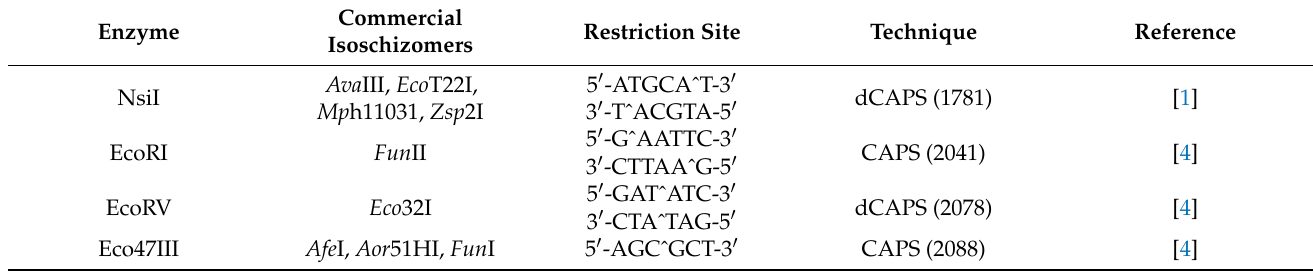
Table 3. Restriction Sites of CAPS and D CAPS Restriction